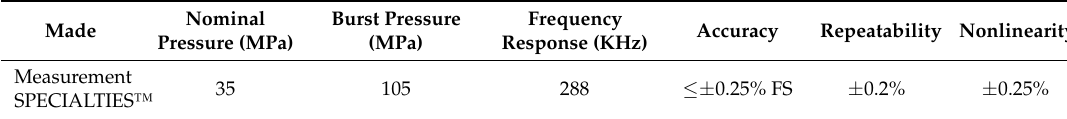
Table 2. Main parameters of the pressure transducer of XPM 10.